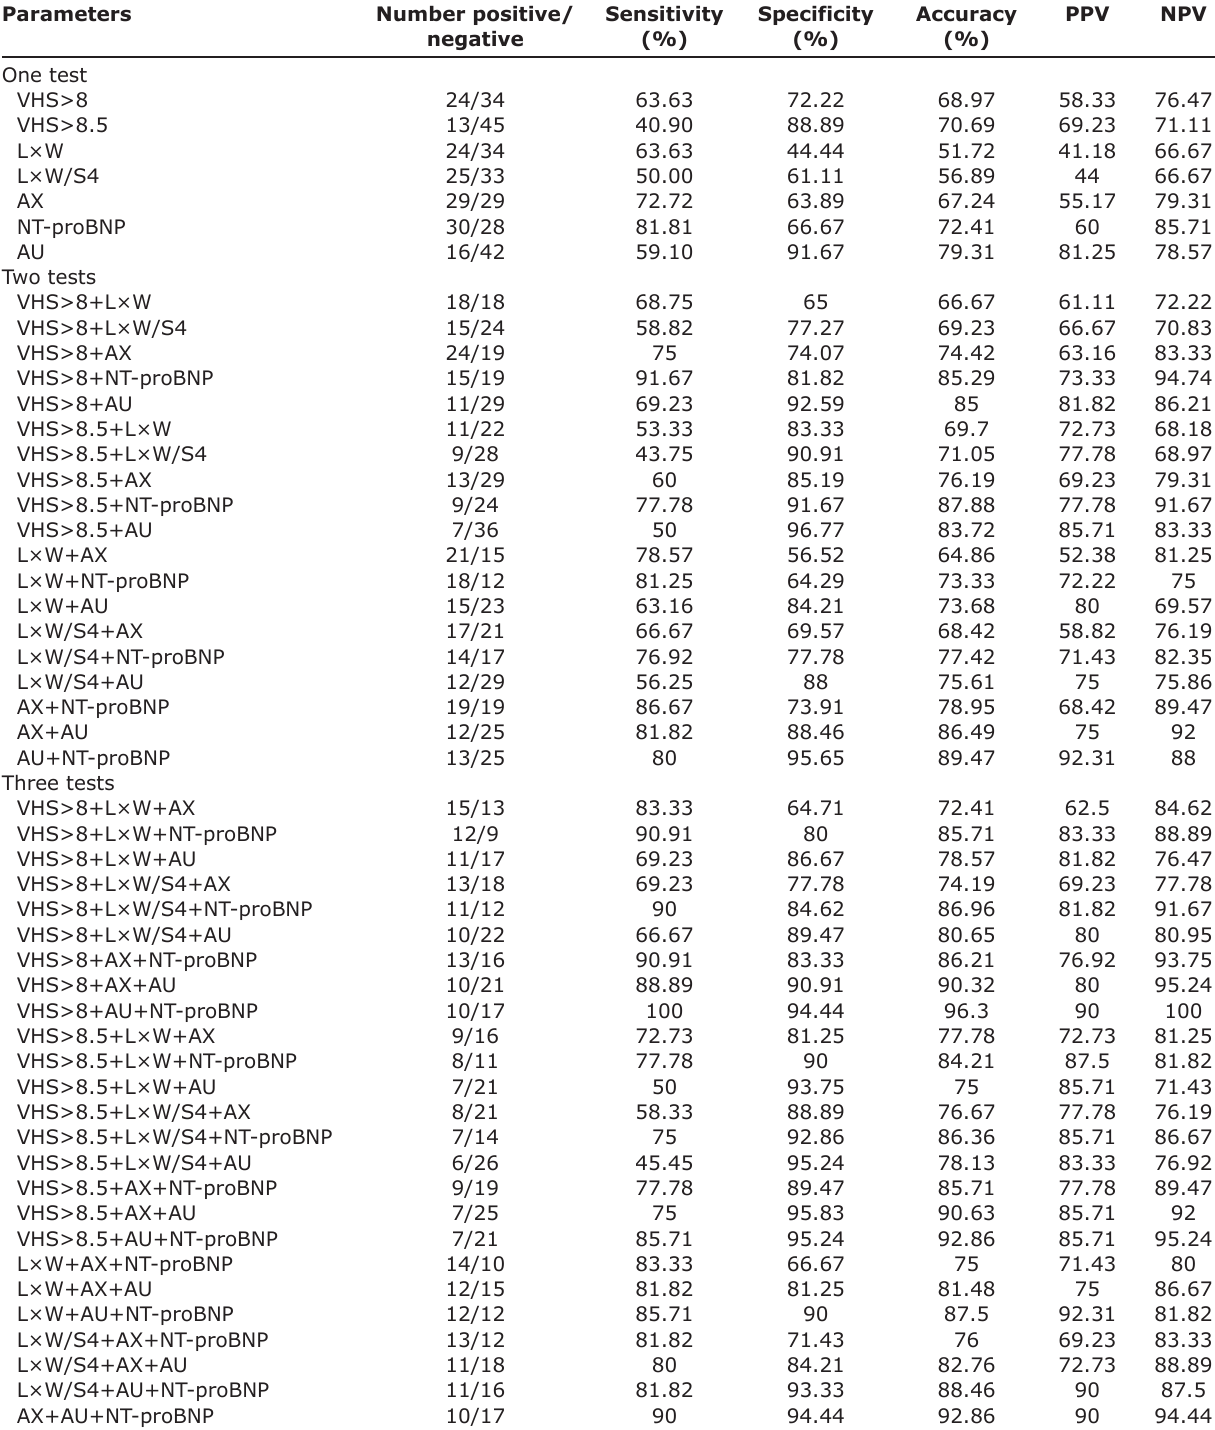
Table-3: Specificity, sensitivity, accuracy, positive predictive, and negative predictive values of tests for distinguishing cats with (n=22) and without congestive heart failure (n=36).